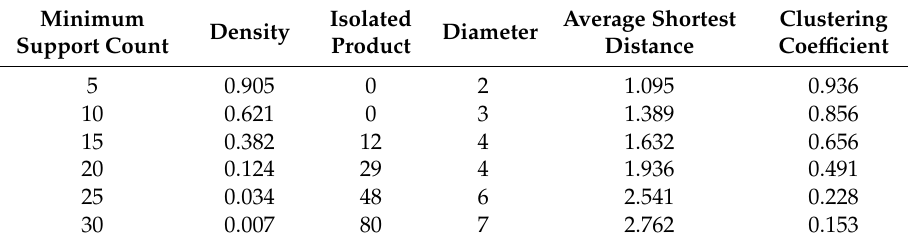
Table 5. Five indexes under di ff erent minimum support count in TBN.